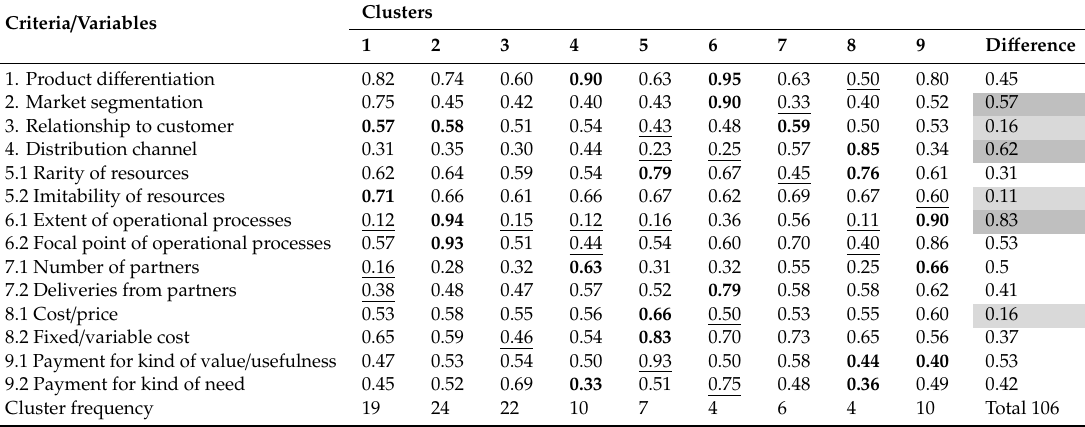
Table 3. Normalized results of cluster